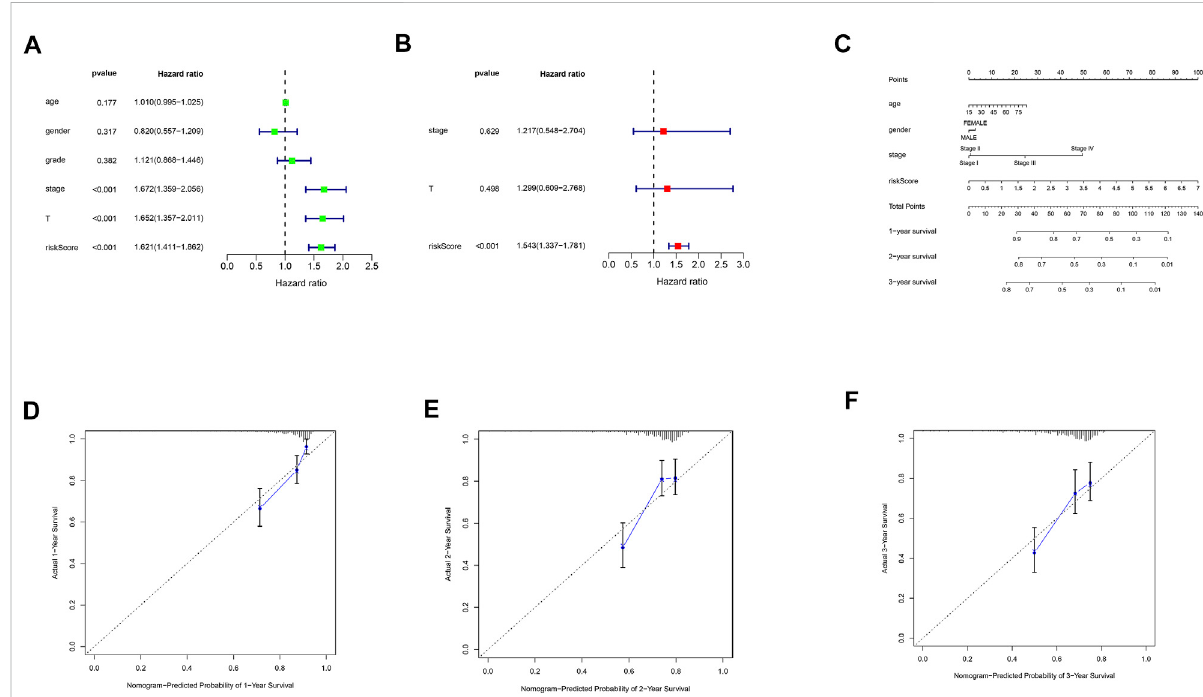
FIGURE 6 Nomogramconstructionandcalibrationplots. (A) univariatecoxregressionanalysisofclinicalcharacteristicsandriskscore. (B) multivariatecox regression analysis of prognosis-related clinical characteristics and risk score. (C) nomogram based on age, gender, stage and risk score. (D) calibrationplotof thenomogramfor the fi rst year. (E) calibrationplot ofthe nomogram for thesecond year. (F) calibrationplotof thenomogramfor the third